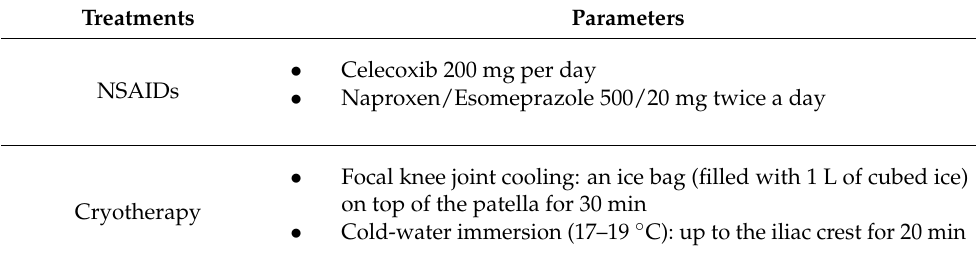
Figure 1. Magnetic resonance images for diagnosis (left: ( A ); right: ( C )) and arthroscopy images ( B , D – F ). Note that ( E , F ) are images obtained after surgery. Table 1. Summary of postoperative